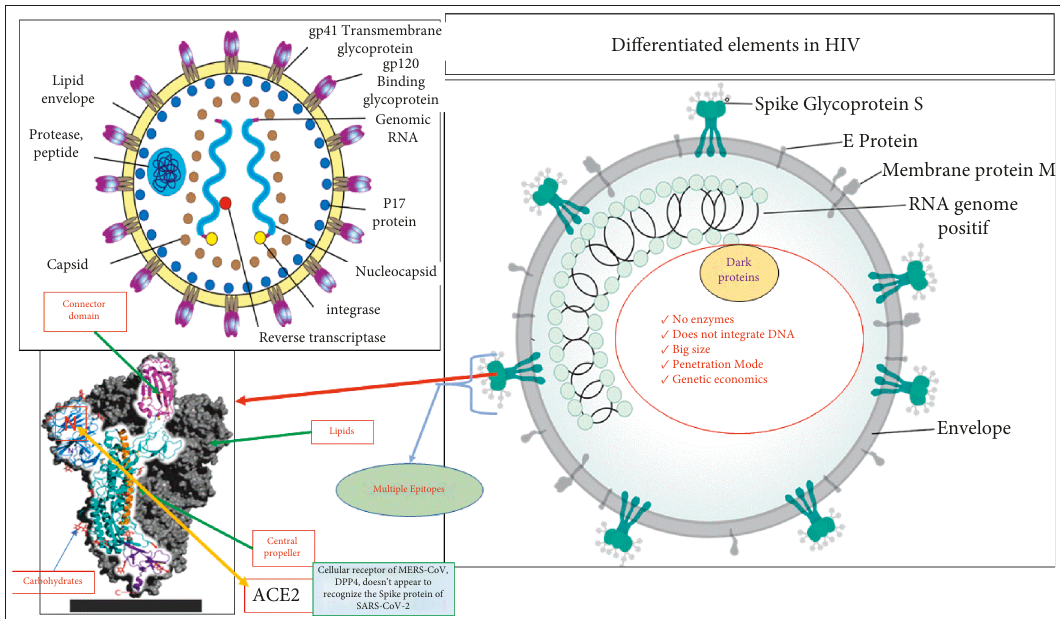
Figure 2: Structure and differentiated elements between SARS-CoV-2 and HIV (Sources: UCL/AUF; https://en.wikipedia.org completed by this study).